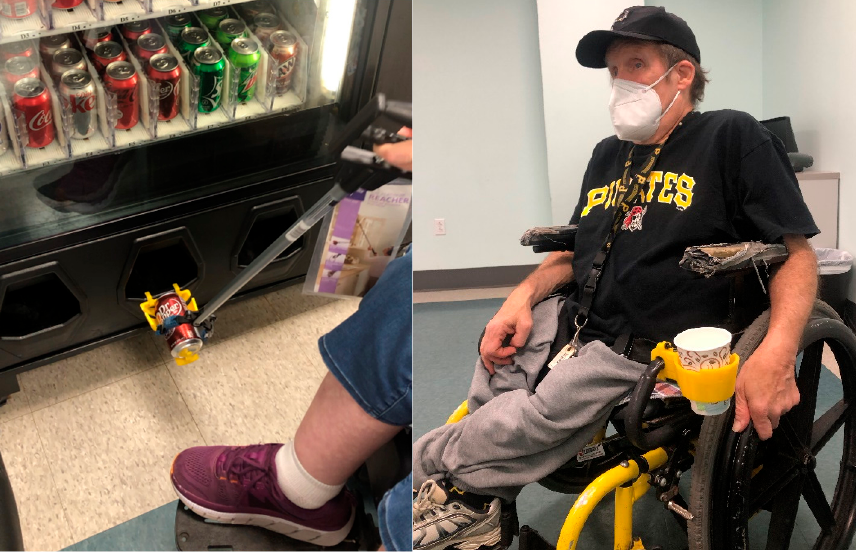
Figure 4. AT built for daily